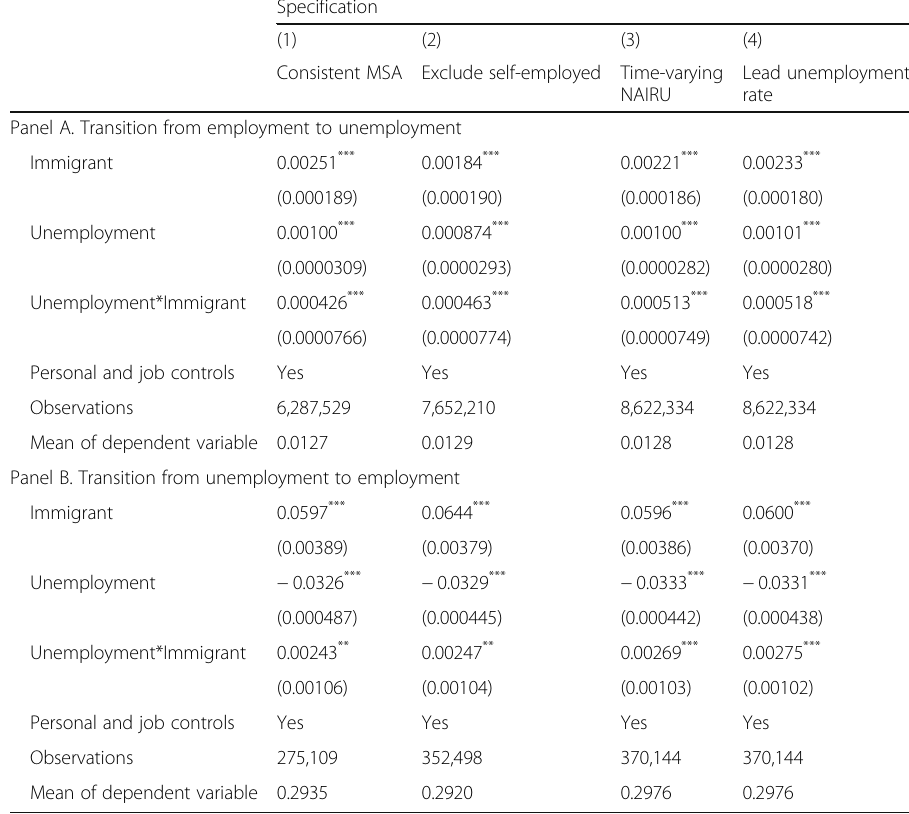
Table 5 Robustness checks: matched CPS data, 1996 –